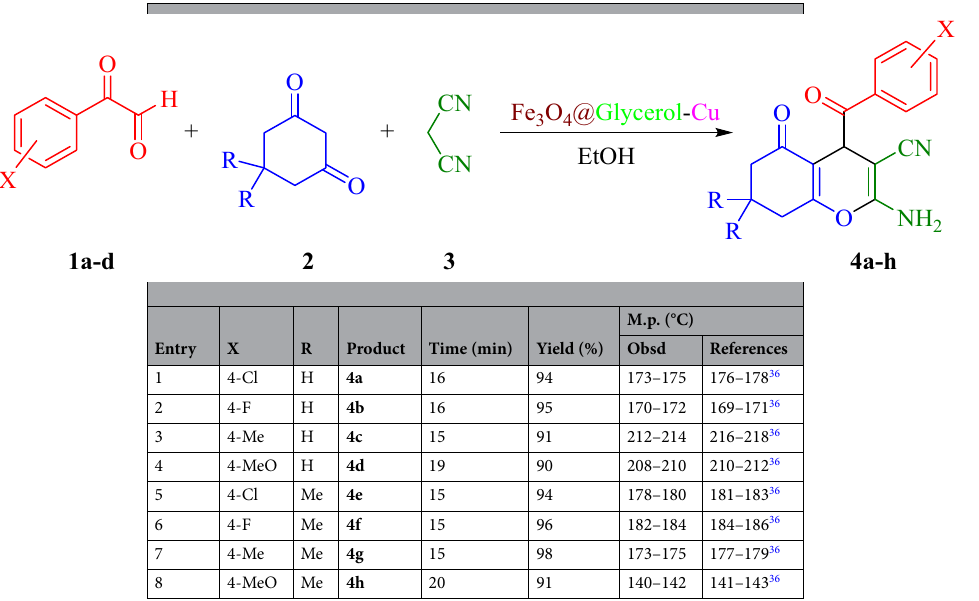
Table 2. Fe 3 O 4 @Glycerol-Cu nanocatalyst the one-pot synthesis of products 4a–h in